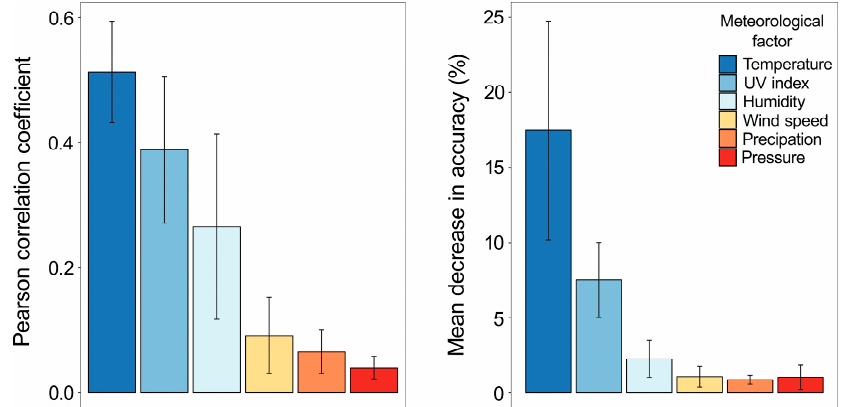
Figure 3. Association between meteorological factors (temperature, UV index, humidity, wind speed, precipitation, and pressure) and influenza activity in six Northern Europe countries averaged for the period from week 35 of 2010 and week 34 of 2017. ( Left ) Correlation analysis between meteorological factors and influenza activity. ( Right ) Contribution of each meteorological factor to predictive performance of machine-learning Random Forest models trained to predict the influenza virus (IV) activity in six Northern European countries. Contribution is measured as percentage mean decrease in accuracy (the higher the bar, the more important the feature is). Both metrics are averaged for the period from 2010 to 2017 epidemic seasons. Each error bar shows a 95% confidence interval for the mean of six countries ( n = 6).